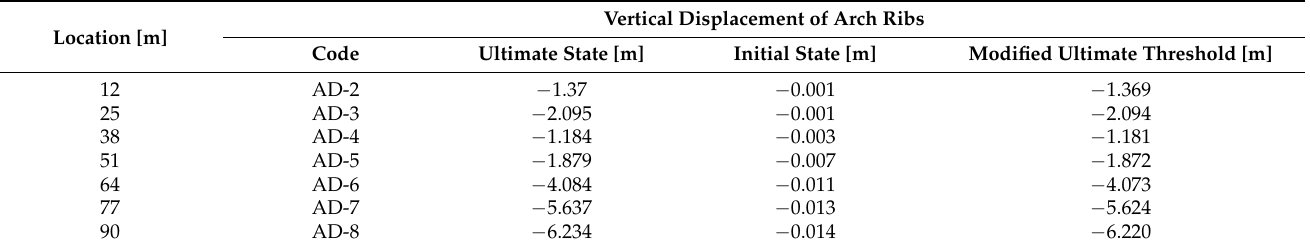
Table 7. Ultimate displacement thresholds of arch ribs.